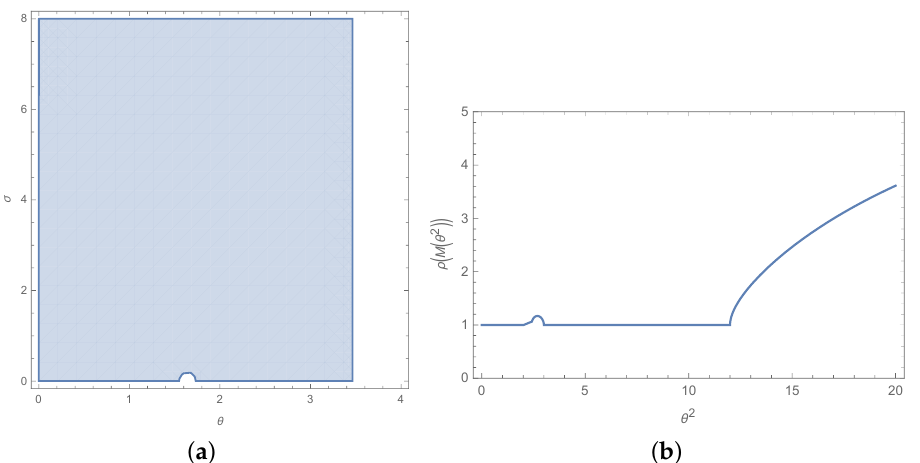
Figure 1. ( a ) The stability region for the simplest 2-step block method plotted in the ( θ , σ ) -plane and ( b ) the periodicity interval for the simplest 2-step block method plotted in the ( θ 2 , ρ ( M ( θ 2 ))) -plane when δ = 0 ( σ = 0).